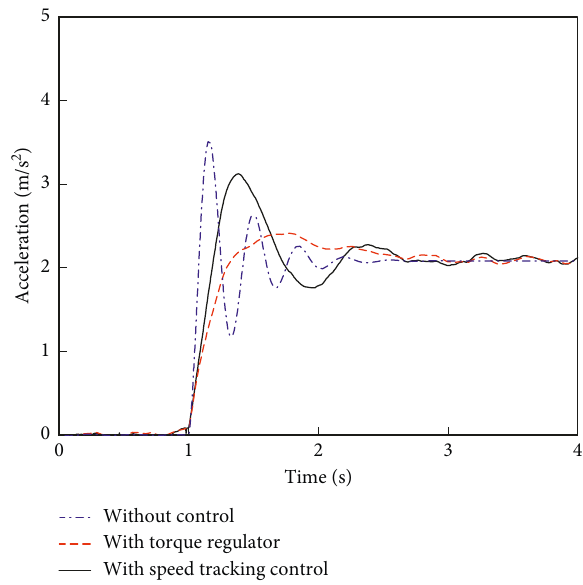
Figure 5: Vehicle longitudinal acceleration.